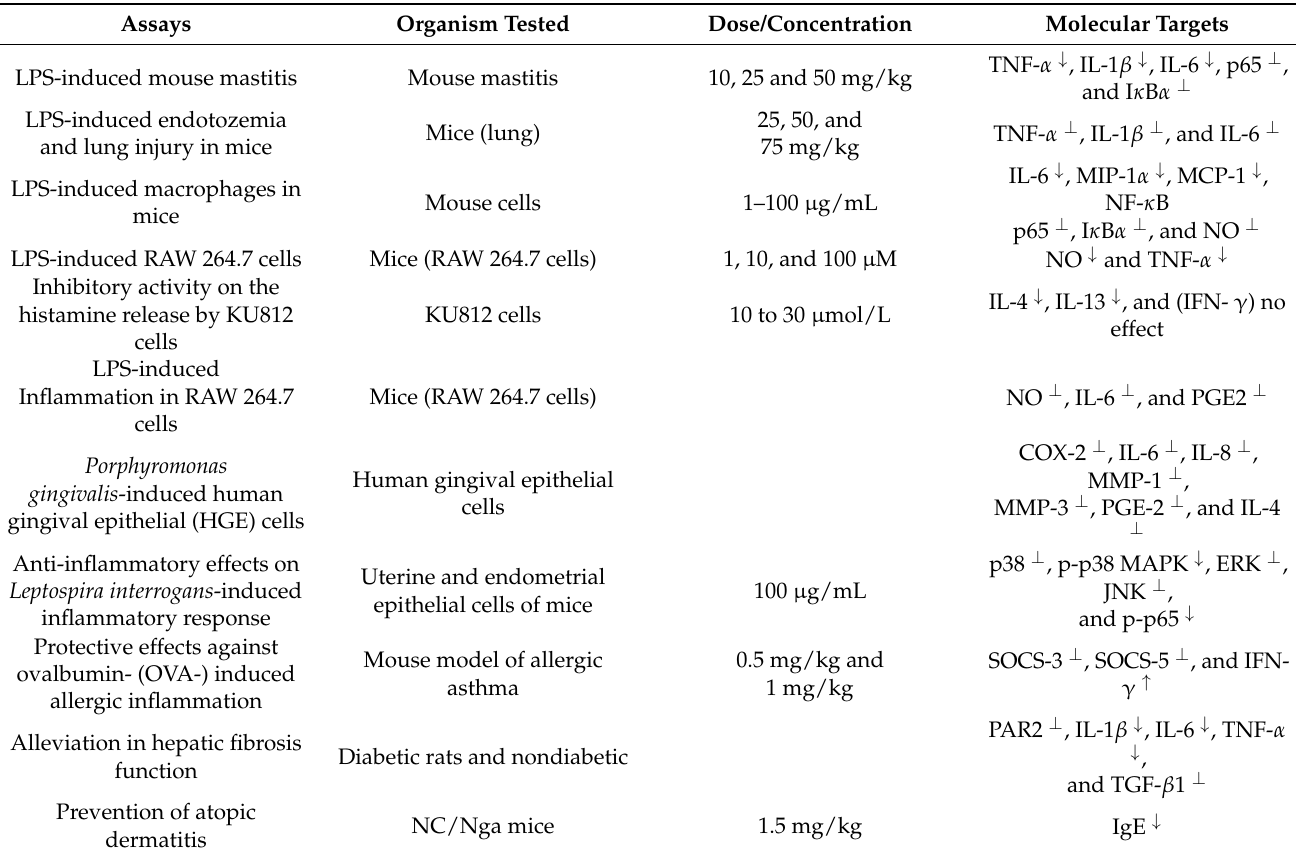
Table 2. Anti-inflammatory activities of astragalin in vitro and in vivo. Reproduced from